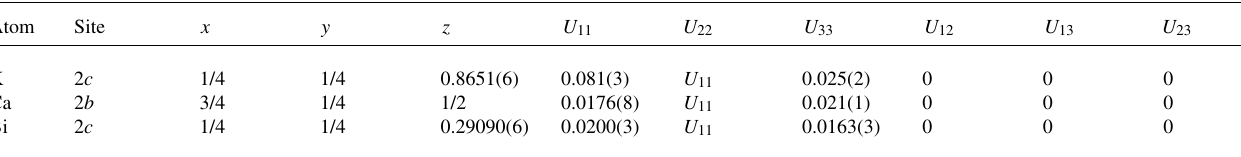
Table 2. Atomic coordinates and displacement parameters (in Å 2 ) .